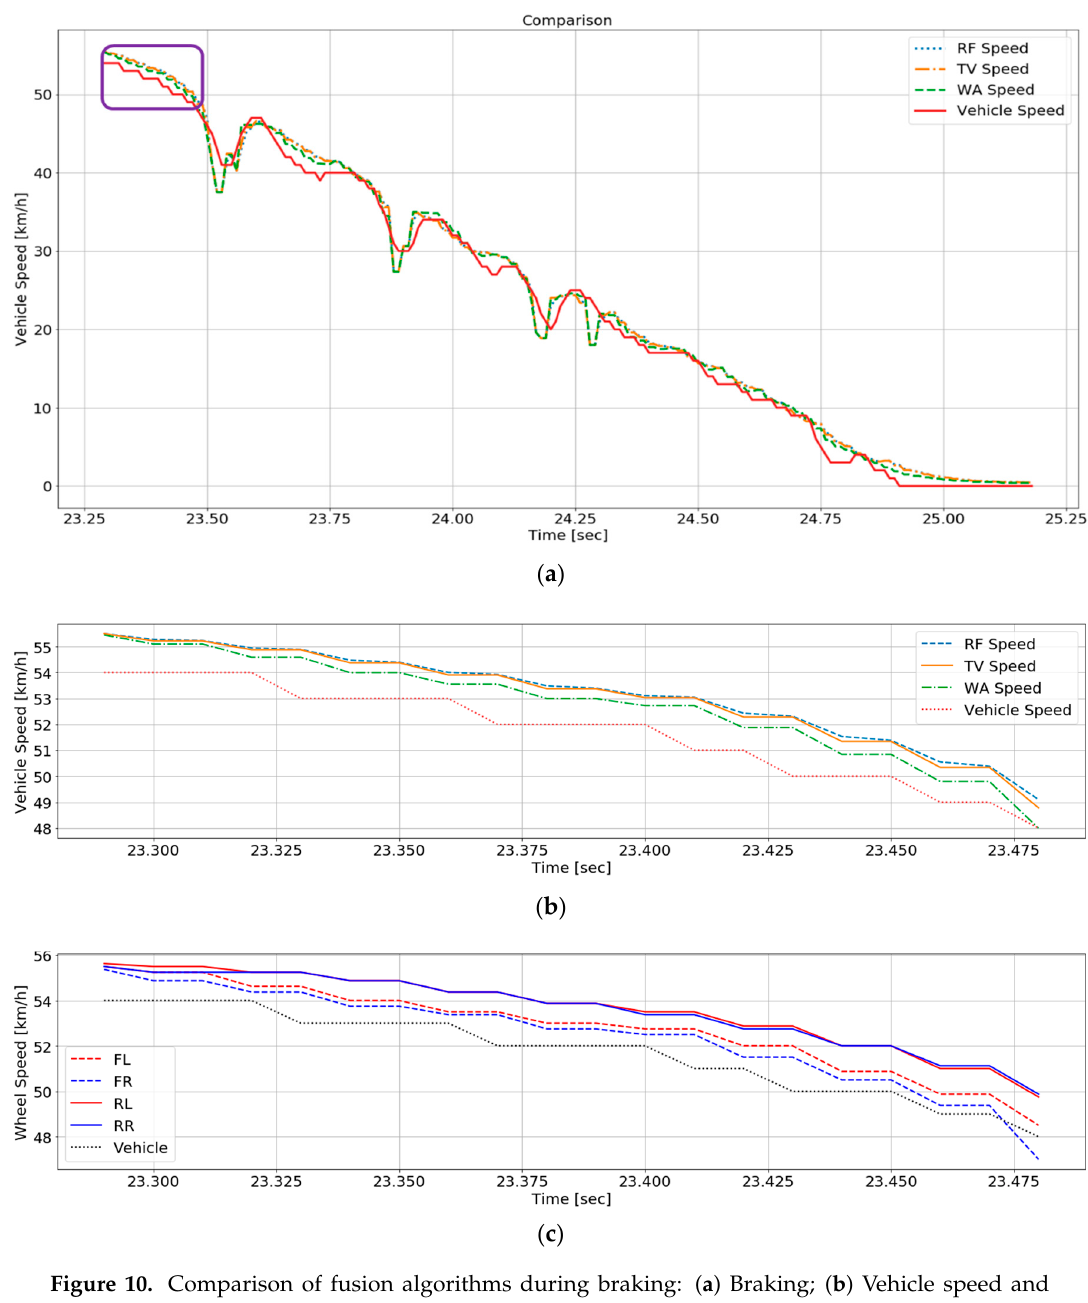
Figure 10. Comparison of fusion algorithms during braking: ( a ) Braking; ( b ) Vehicle speed and estimated speed; ( c ) Vehicle speed and wheel speed to inject false data into.